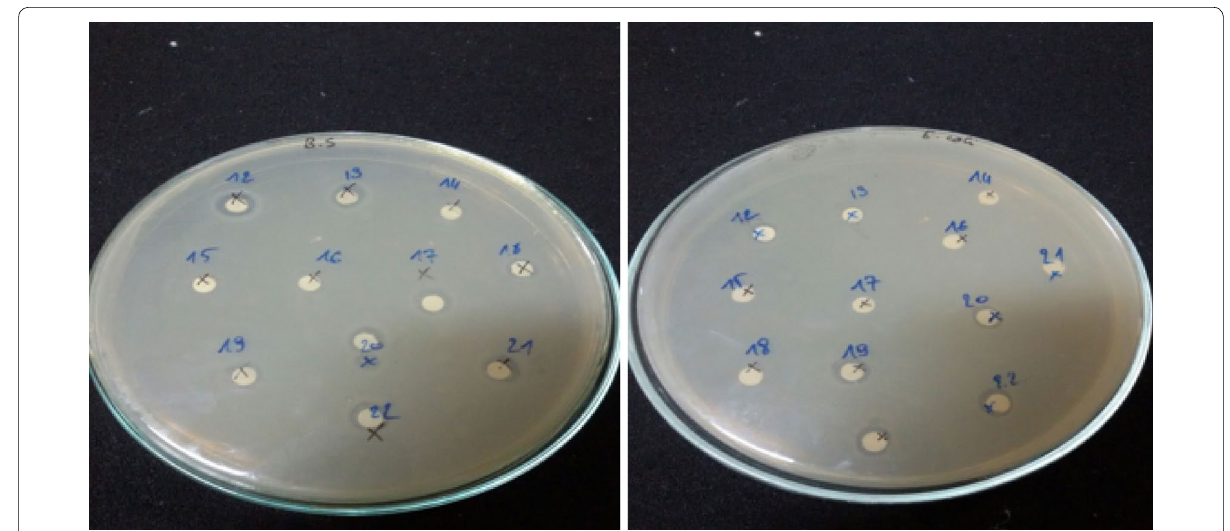
Fig. 16 Sensitivity test in agar